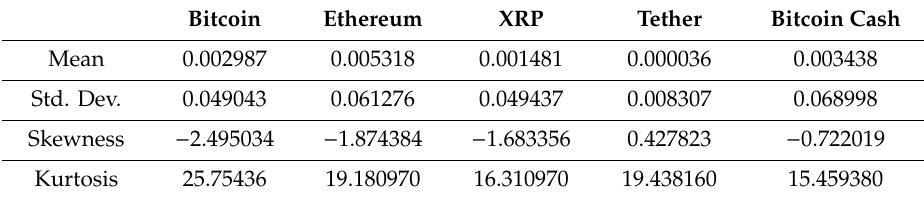
Table 1. Descriptive